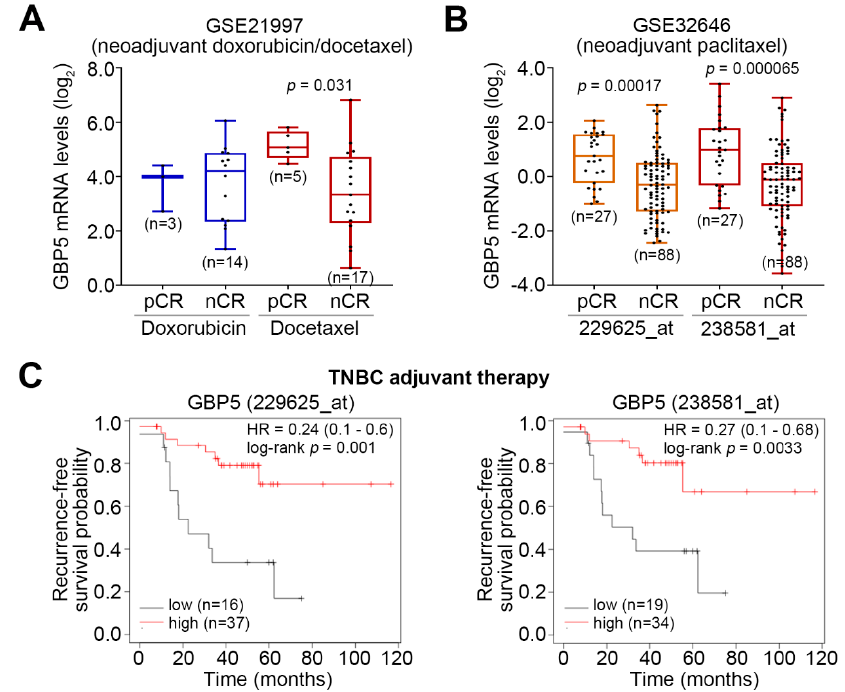
Figure 4. GBP5 upregulation predicts a good responsiveness to the taxol treatment in TNBC patients. ( A , B ) Box plots for the GBP5 mRNA levels in breast cancer patients that were recorded to be pathologic complete response (pCR) or no complete response (nCR) after neoadjuvant doxorubicin or docetaxel therapy from GSE21997 dataset ( A ) and after neoadjuvant paclitaxel therapy from GSE32646 dataset ( B ). In B, 229625_at and 238581_at denote the probe identifiers of GBP5 in the commercial microarray. Student’s t -test was used to analyze the statistical significance. ( C ) Kaplan–Meier analyses using recurrence-free survival condition for GBP5 mRNA levels detected by two probes in K–M Plotter against TNBC patients receiving adjuvant chemotherapy.